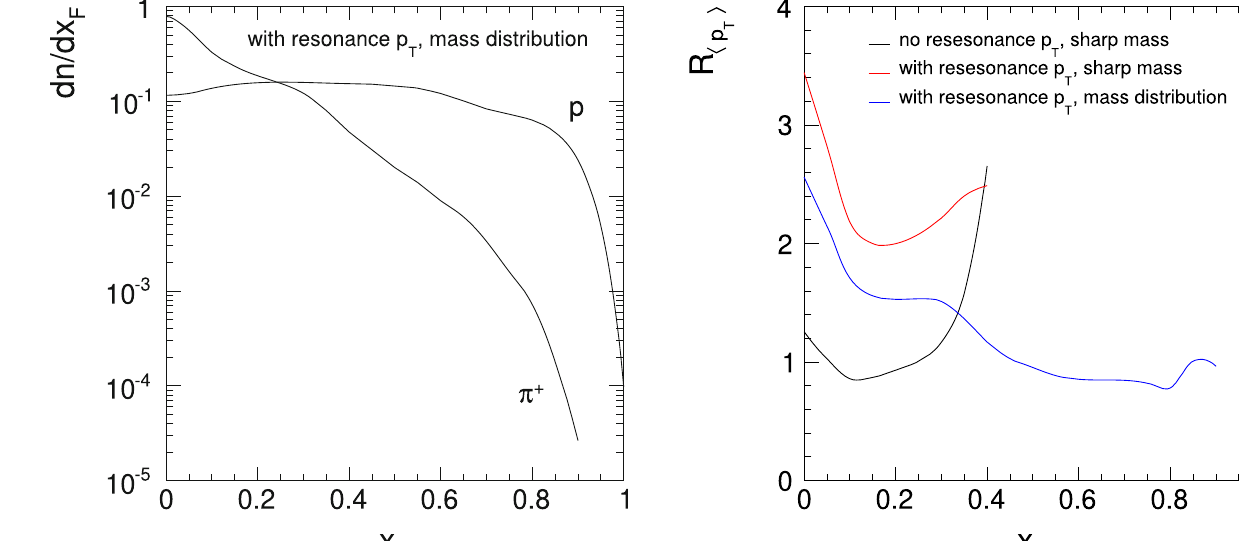
is shown in Fig. 157.